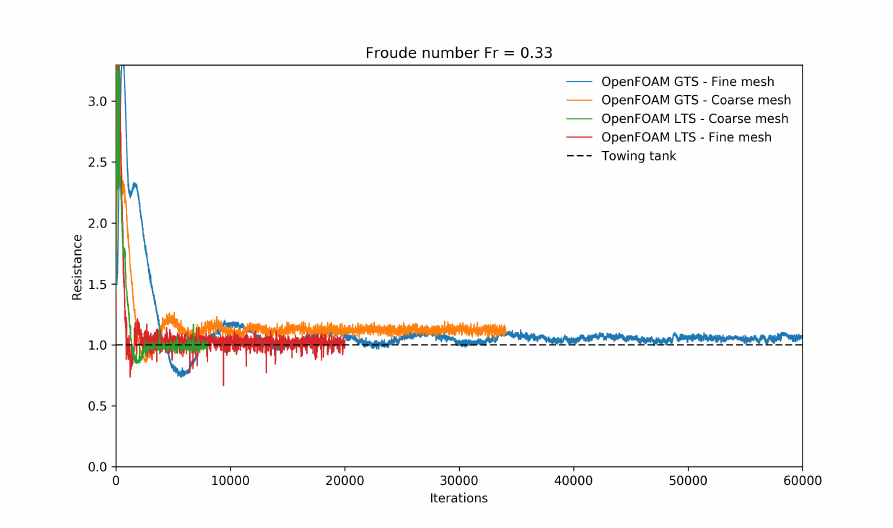
Figure 9. Comparison of the normalized resistance as a function of the iteration number for the coarse and fine meshes. In the legend, LTS (local time-stepping) corresponds to the steady solution, and GTS (global time-stepping, i.e., a time-step identical for all control volumes) corresponds to the transient solutions.